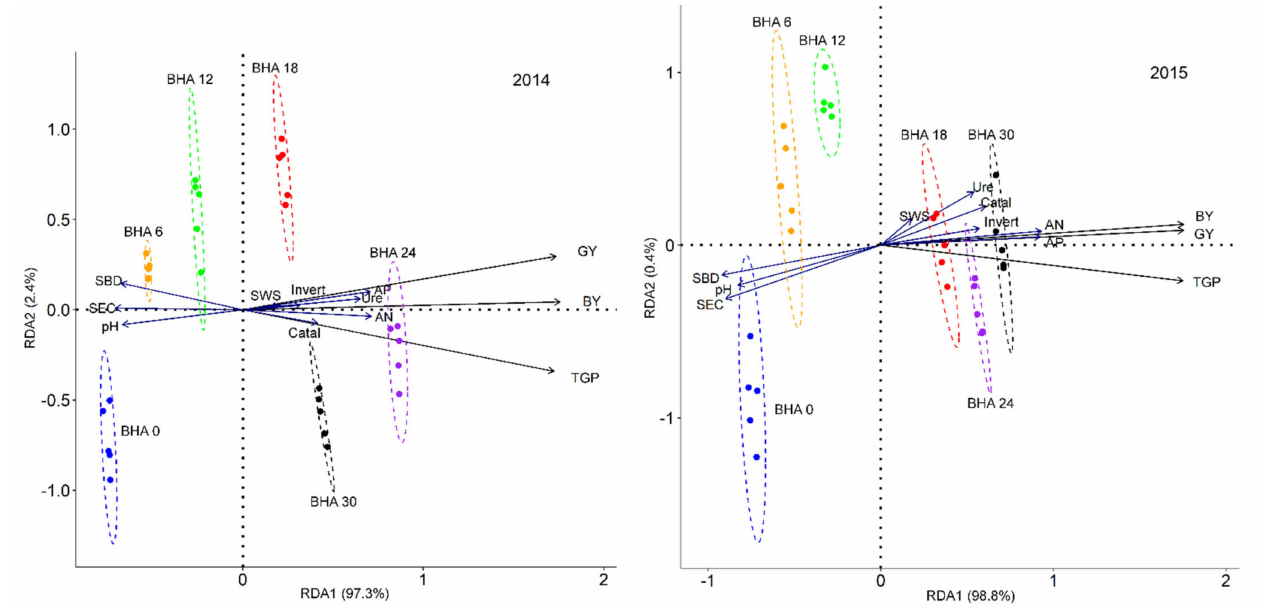
Figure 5. Redundancy analysis (RDA) of the associations of crop performance measurements (total grain protein, grain, and biomass yield) with soil biological, physicochemical properties at a depth of 10–20 cm in 2014 and 2015. BHA 0, BHA 6, BHA 12, BHA 18, BHA 24, and BHA 30 represent none, 6, 12, 18, 24, and 30 Mg ha − 1 one-time application in 2011 of bentonite-humic acid (BHA) treatment, respectively. SBD, soil bulk density; SEC, soil electrical conductivity; SWS, soil water storage; Ure, urease; Invert, invertase; Catal, catalase; AN, alkaline nitrogen; AP, available phosphorus; BY, biomass yield; TGP, total grain protein; GY, grain yield. The length of the arrow indicates the relative variance in the RDA axis explained by that factor; the cosine of the angle between two arrows for two variables represents the correlation between these two